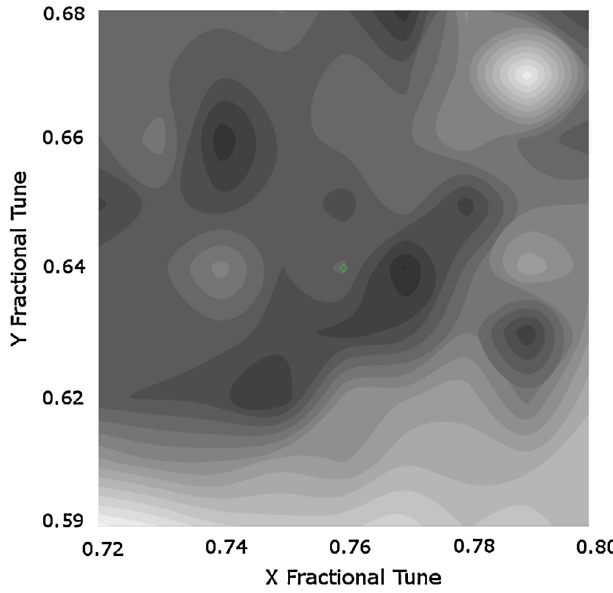
FIG. 12. A contour plot of the average standard deviation for 100 different sets of placement offsets. The darker areas show a smaller standard deviation of offset, which means they are less sensitive to errors. The green e symbol represents the location of the ideal tunes.